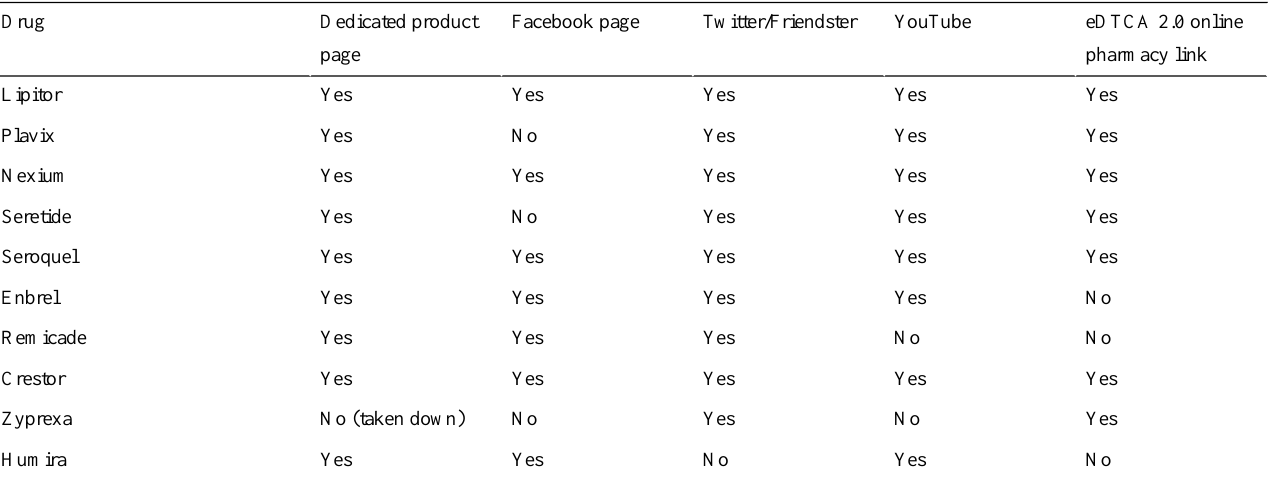
Table 2. Top 10 grossing drugs and eDTCA 2.0 a